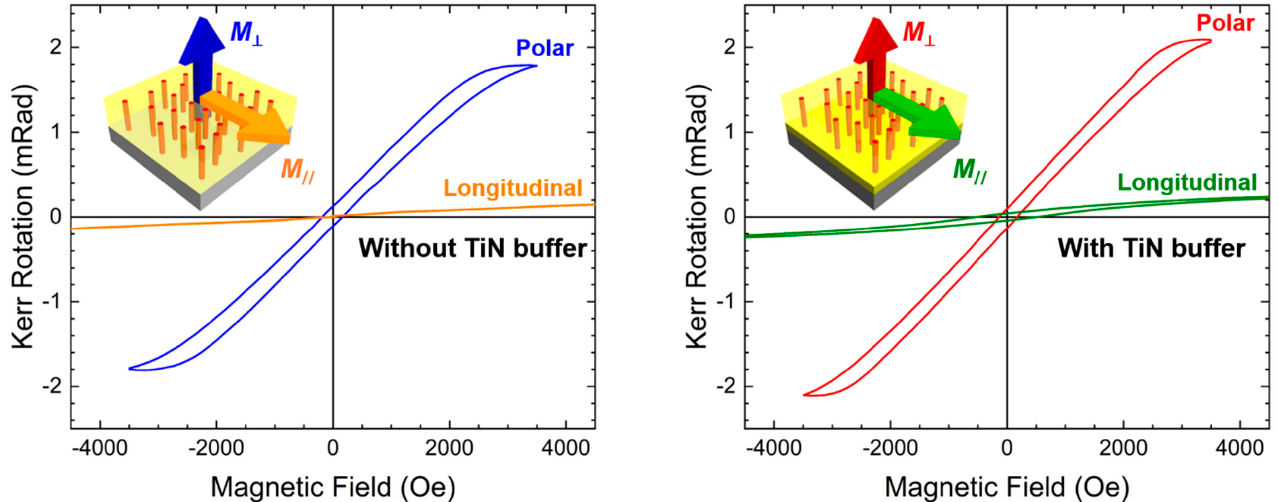
Figure 6. The room temperature polar and longitudinal magneto-optical Kerr effect data of the TiN–Fe films grown without a TiN buffer ( left ) and with a TiN buffer ( right ).